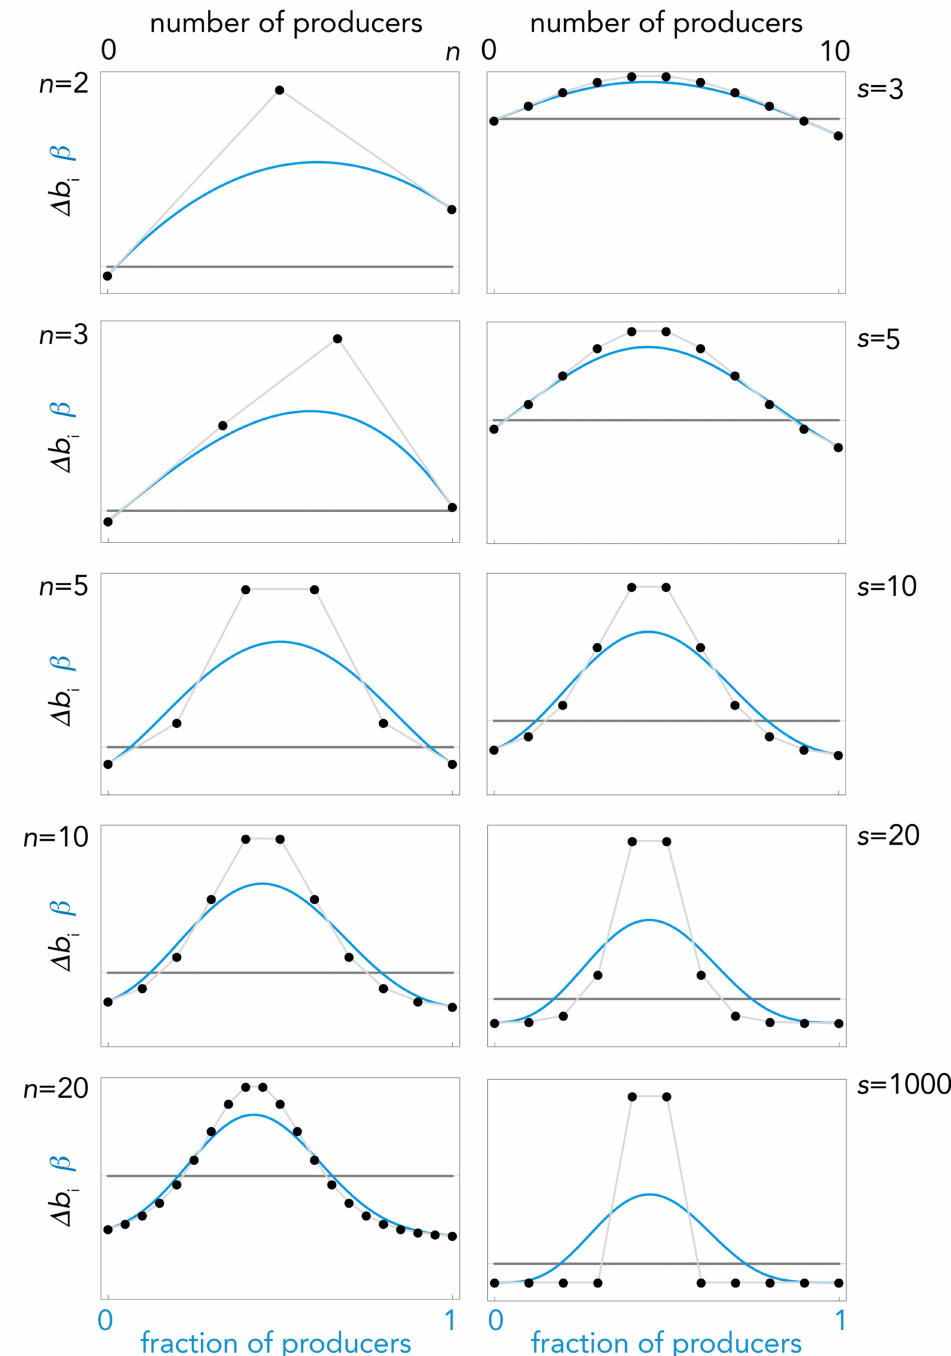
Figure 5. Effect of s and n . The gradient of selection β (continuous blue line) and its Bernstein coefficient ∆ b i (dotted line) in public goods games with sigmoid benefits, for different values of s ( n = 10, h = 0.4, c = 0.05) or for different values of n ( s = 10, h = 0.4, c = 0.05); squares show the equilibria (full: stable; empty: unstable); arrows show the direction of the dynamics (determined by the sign of the gradient of